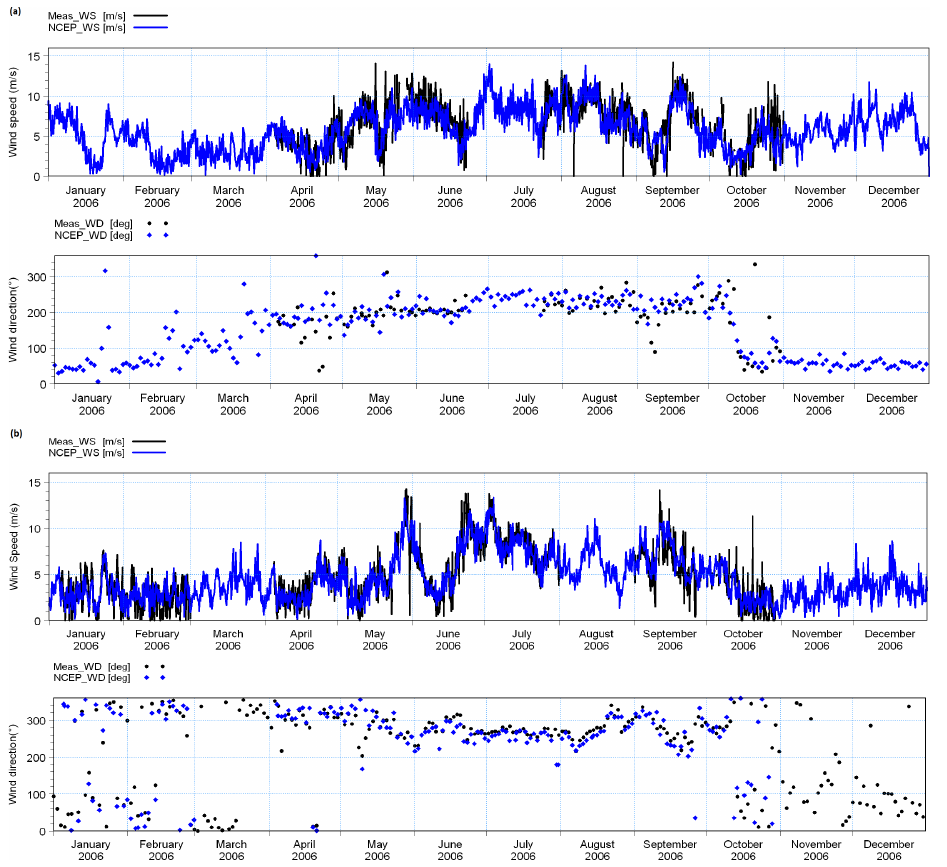
Fig. 2. Comparison of time series of NCEP winds (blue line) with buoy winds (black line) at two locations: (a) DS5 (Bay of Bengal) and (b) DS2 (Arabian